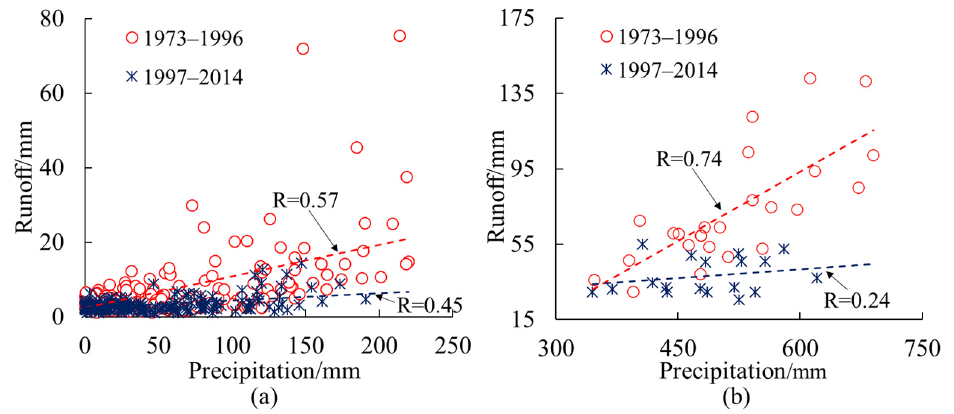
Figure 4. Relationships between precipitation (mm) and runoff (mm) on monthly and annual scales. ( a ) monthly scale; ( b ) annual scale.